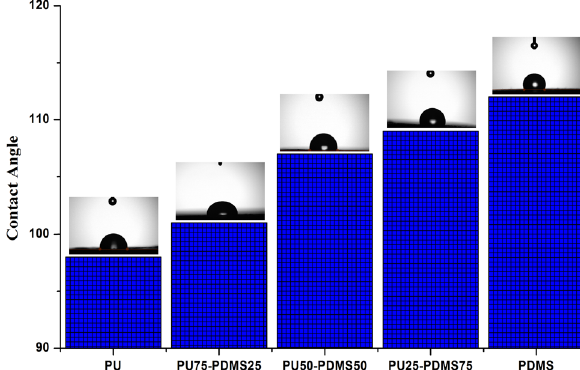
Figure 7: The contact angle of PU – PDMS polymer coatings on AISI 316L.